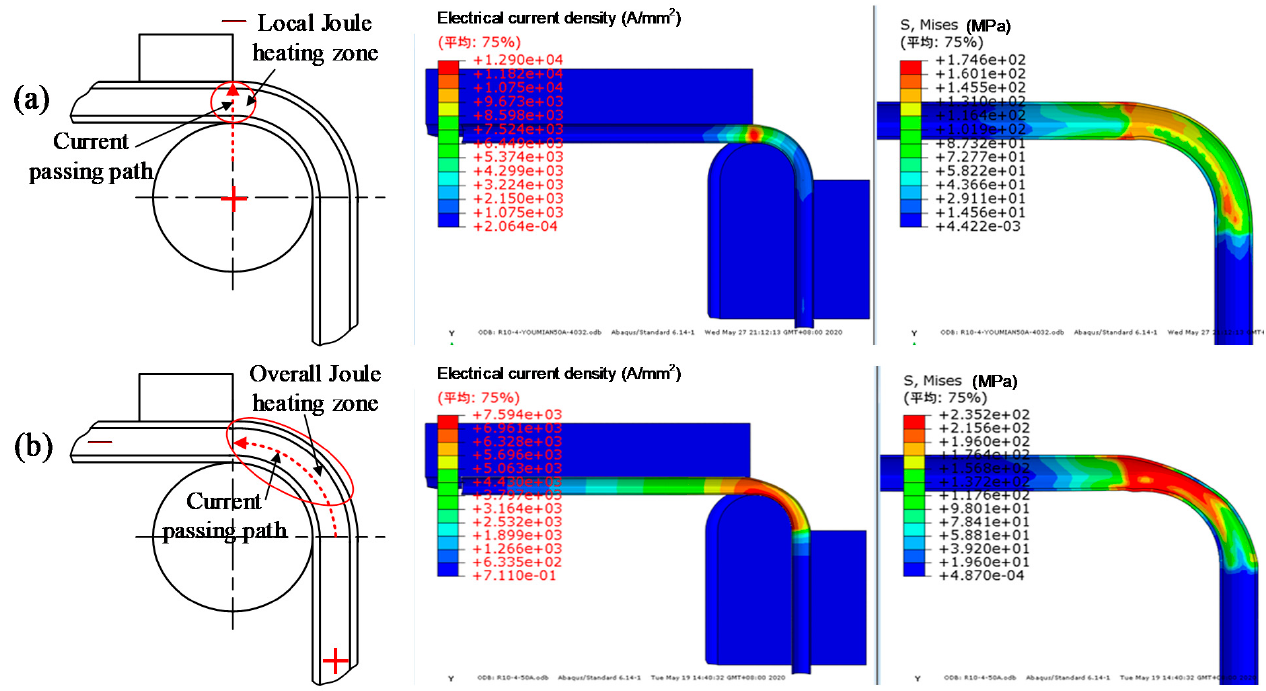
Figure 9. A comparison of current density and stress distributions under different electrical current passing path in EA RDB: ( a ) die-to-die, ( b ) end-to-end.